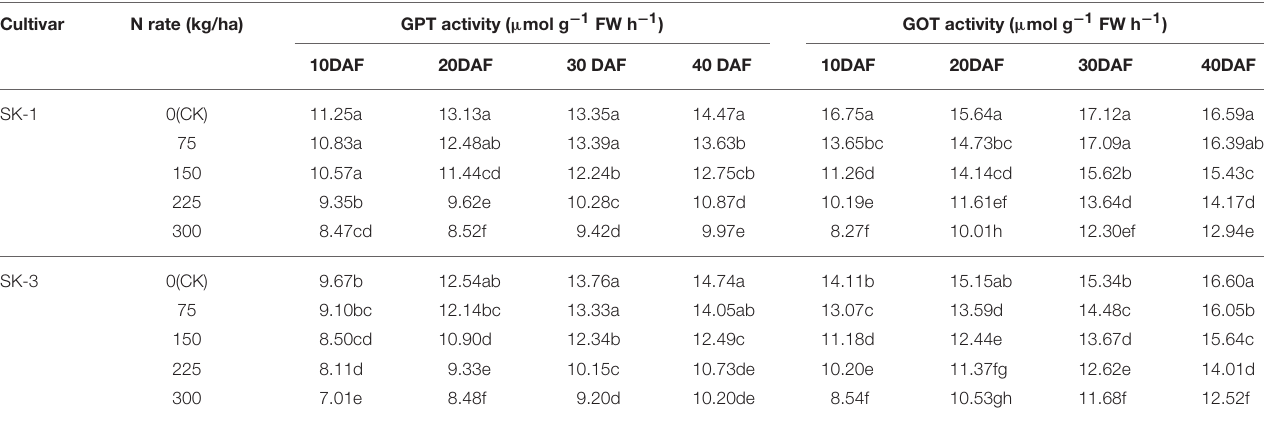
Symbol SK-1 and SK-3 are cultivar Sikang1 and Sikang3 respectively, CK is Control. DAF is acronym of “days after flowering.” Same letter among treatments within each sampling date represent non-significant difference (LSD test at 0.05 significance level).